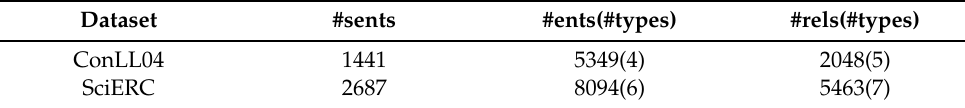
Table 1. Statistics of the